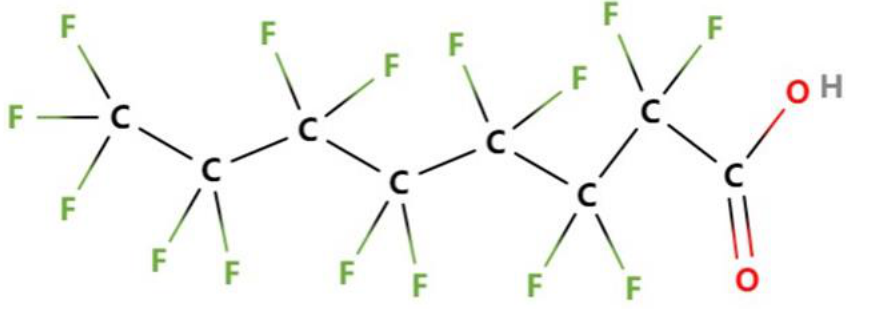
Figure 1. The chemical structure of PFOA.